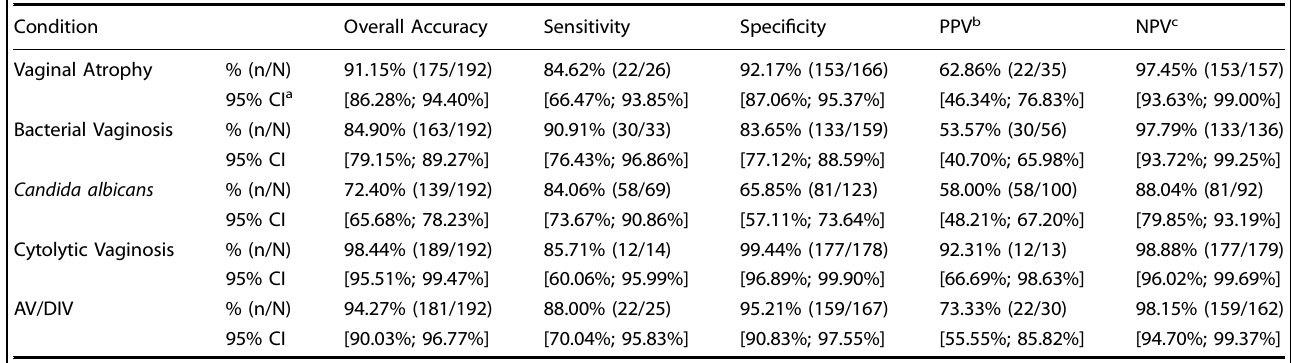
Table 1. Diagnostic Performance of GYNI ™ test compared to a CRS of culture, PCR, and wet mount microscopy. Condition